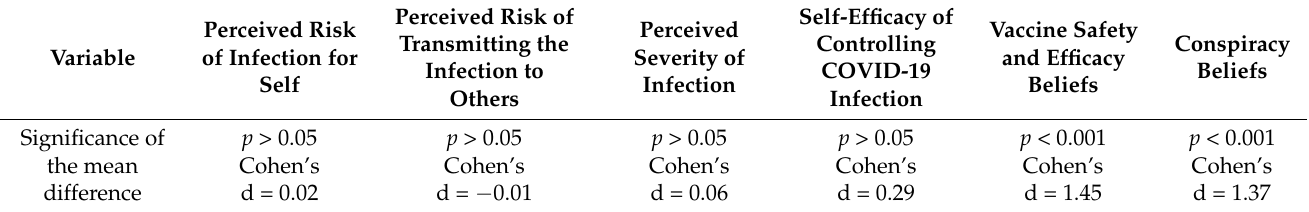
Table 5. Percentage of responses regarding the intention to vaccinate for